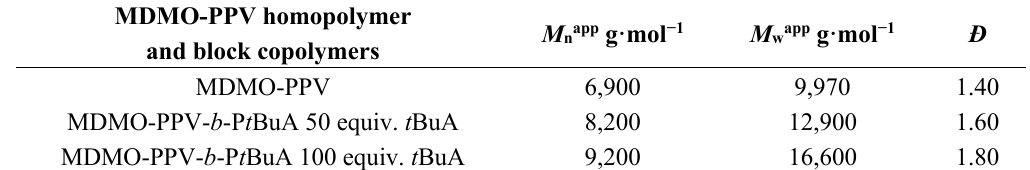
Figure 4 . Molecular weight distributions of MDMO-PPV (black line) and MDMO-PPV- b - P t BuA block copolymers obtained from ATRP with 100 equiv. of monomer followed in time (dotted lines with increasing conversion from left to right). Table 4. Apparent average molecular weights of MDMO-PPV- b -P t BuA block copolymers from ATRP chain extensions using different equiv. of monomer.